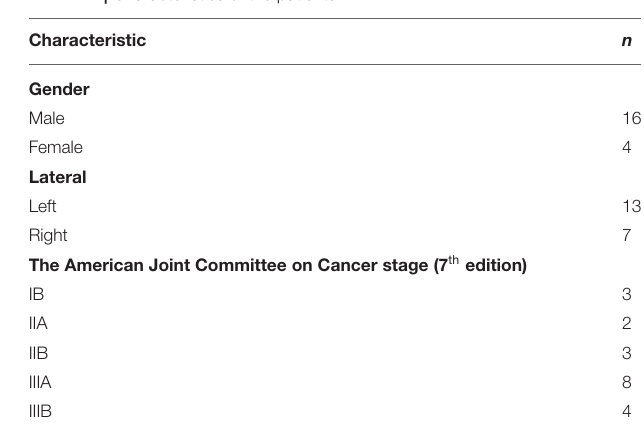
TABLE 1 | Characteristics of the